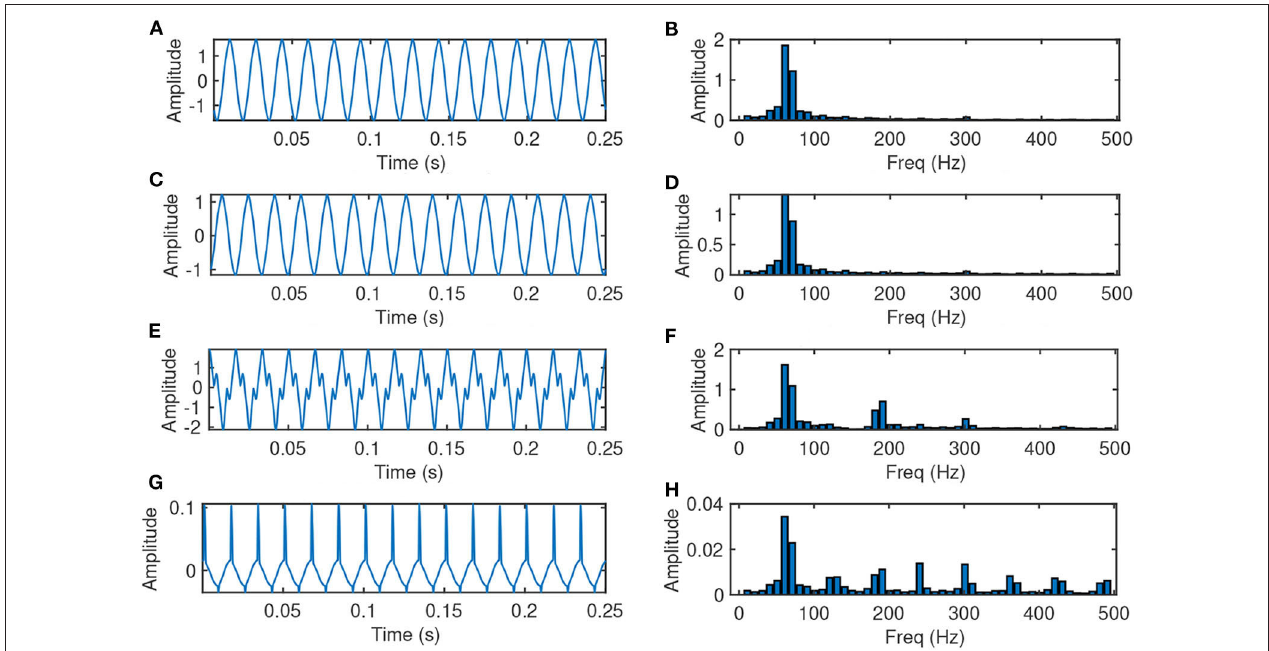
FIGURE 4 | Examples of electrical load sensing events (normalized by the signal energy). (A) Kettle, time domain. (B) Kettle, freq domain. (C) Stove, time domain. (D) Stove, freq domain. (E) Microwave door, time domain. (F) Microwave door, freq domain. (G) Microwave, time domain. (H) Microwave, freq domain.